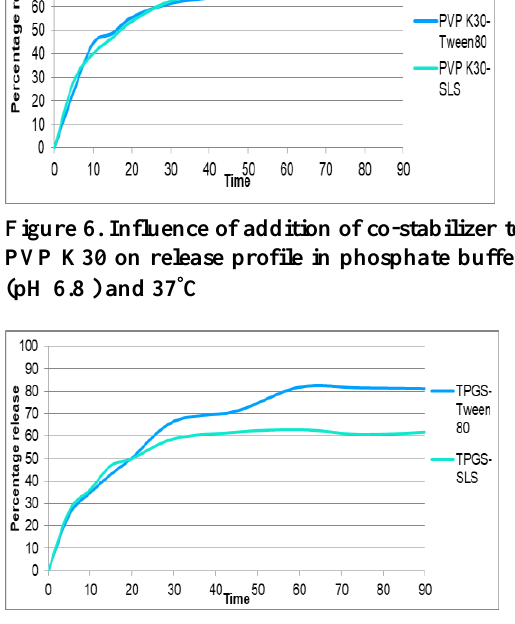
Figure 7. Effect of co-stabilizer to TPGS on release profile in phosphate buffer (pH 6.8 ) and 37 